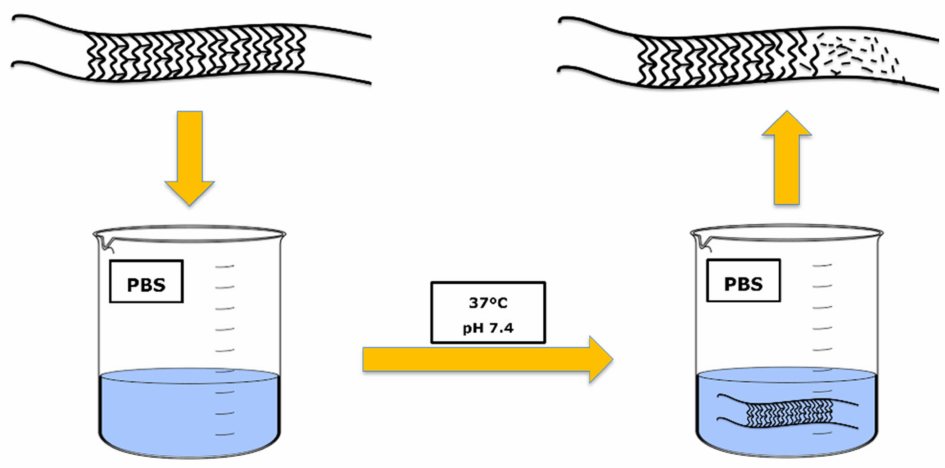
Figure 2. Schematic representation of the in vitro degradation of vascular